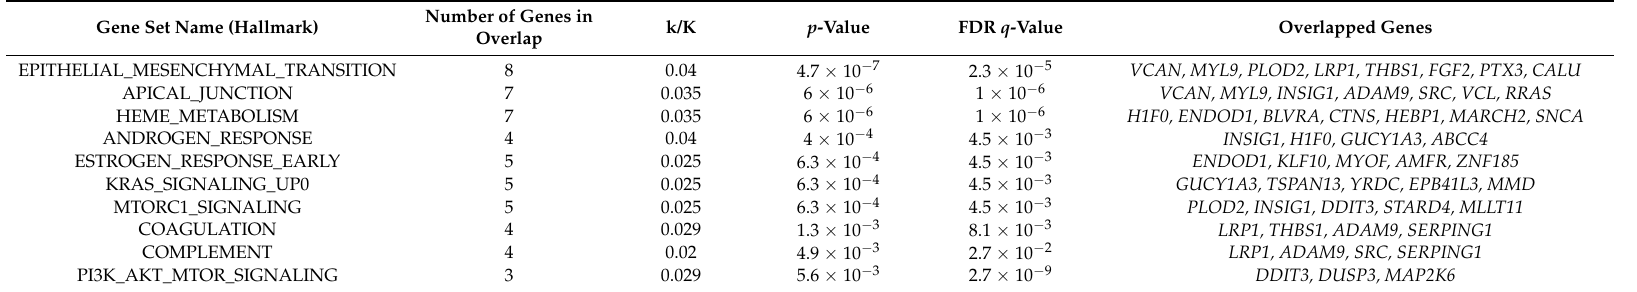
Table 3. Enriched cellular hallmarks in ABCB5 CTC fractions from metastatic melanoma